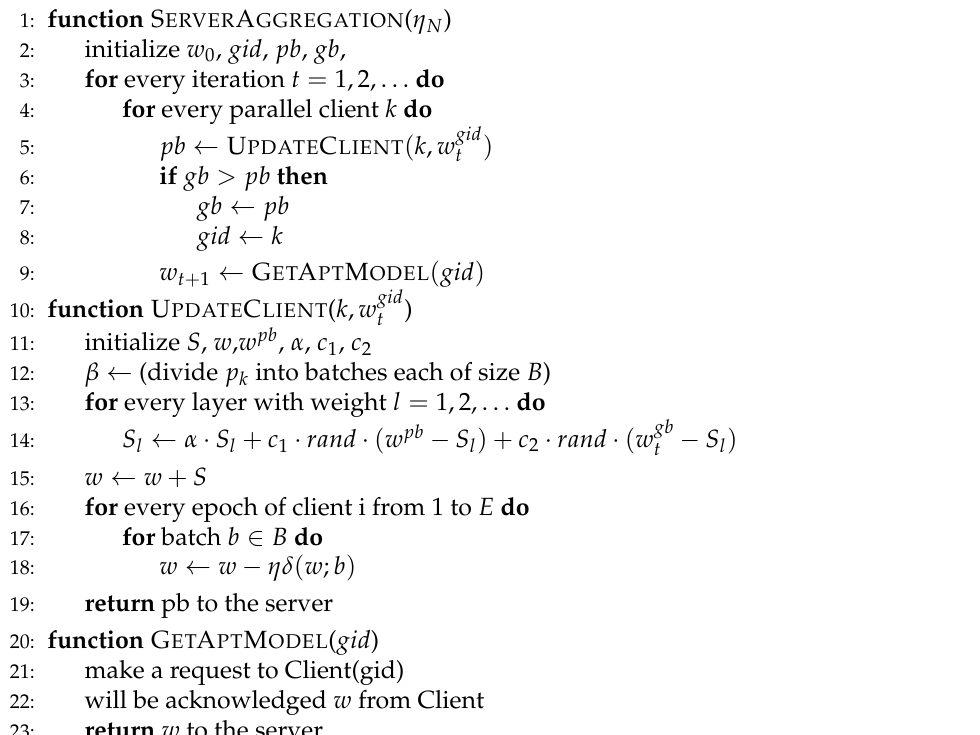
Algorithm 2 Federated Particle Swarm Optimization